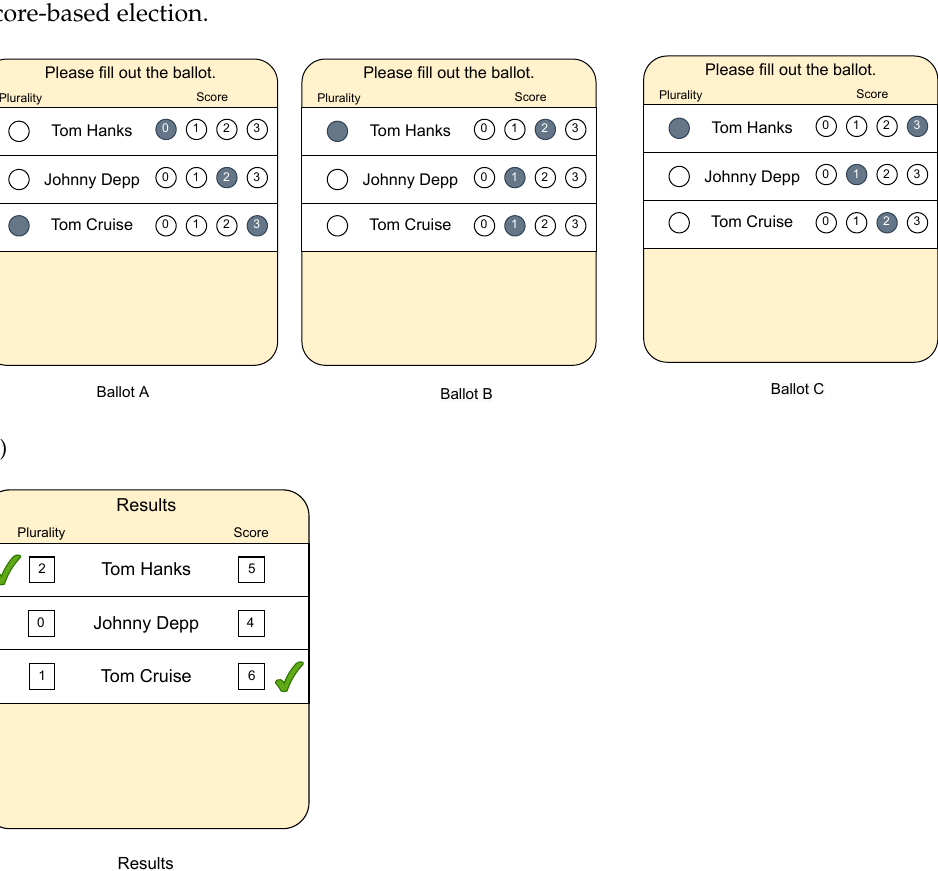
Figure 1. Illustration of a score-based election with three voters and three candidates ( a ). In ( b ), the corresponding plurality vote is visible on the left of each ballot. Notice how plurality voting yields a deceptive result when compared to the score-based result. ( a ) Example of three different votes in a score-based election. The ballot includes three candidates namely Tom Hanks, Johnny Depp, and Tom Cruise. The ballot includes a score of four per candidate. The voter has to select one score per each candidate. ( b ) The results of the score-based and regular